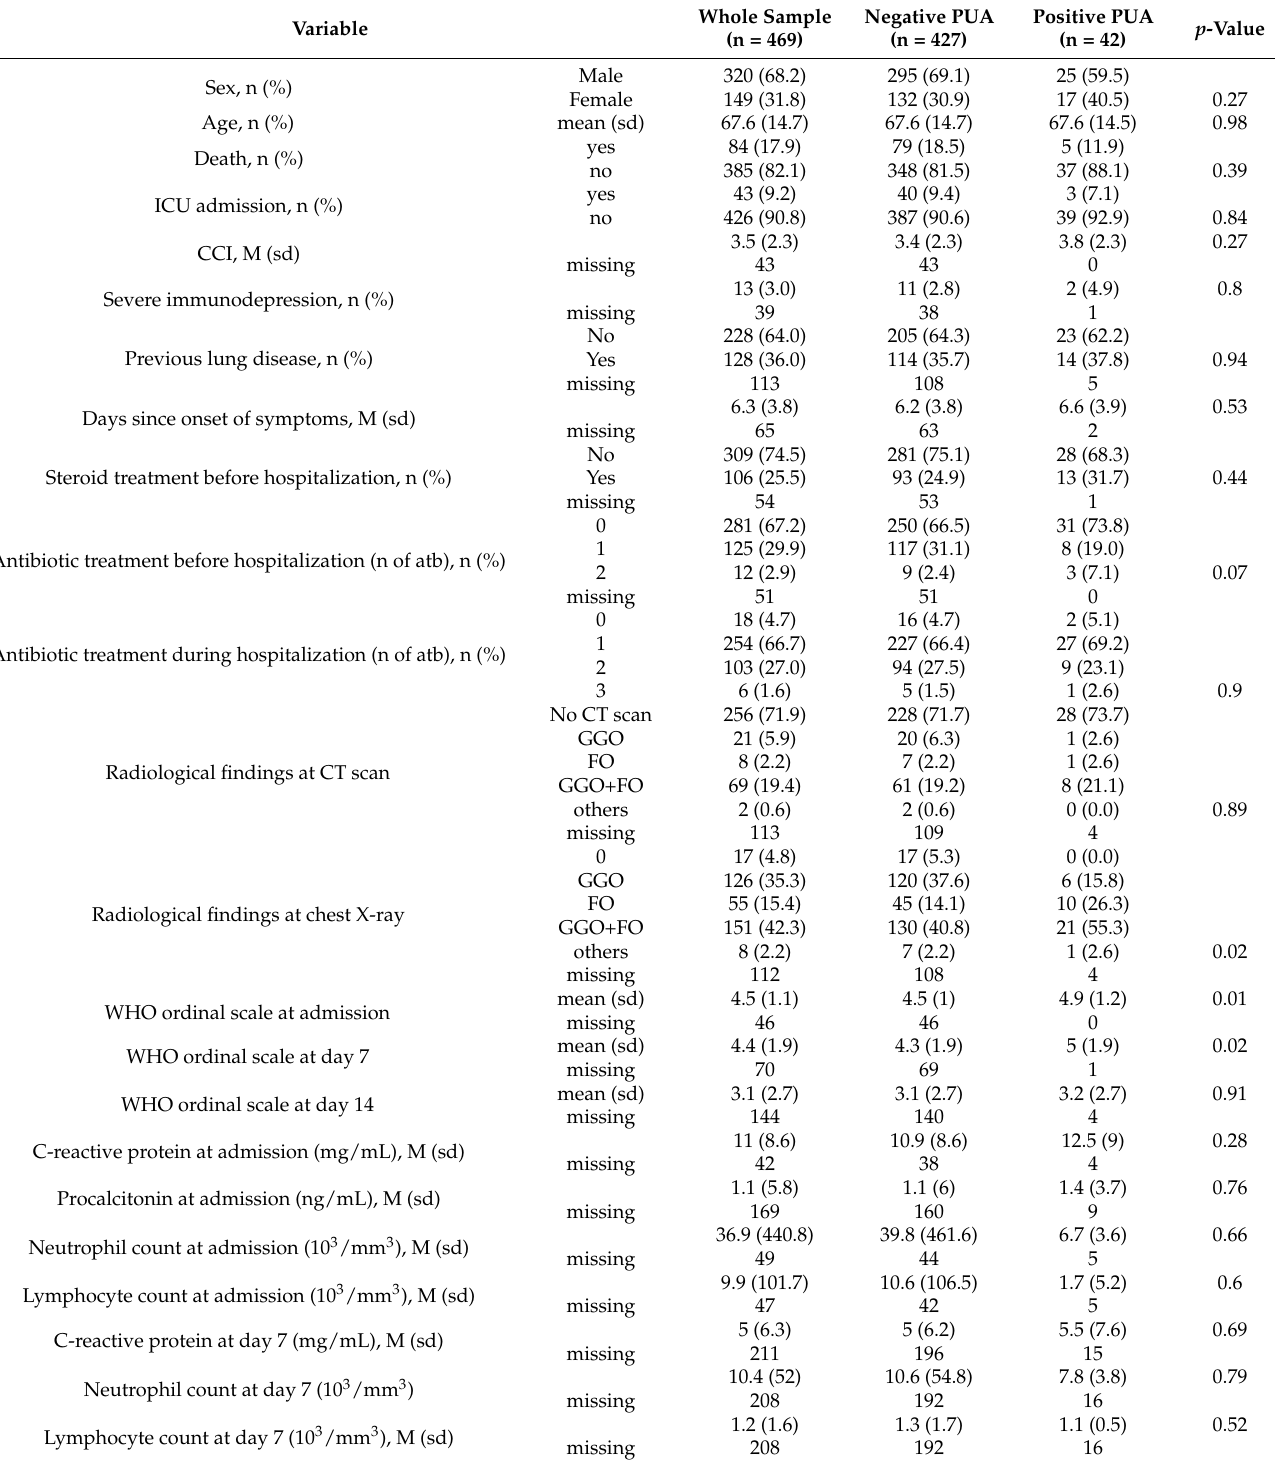
Table 1. Demographic and clinical